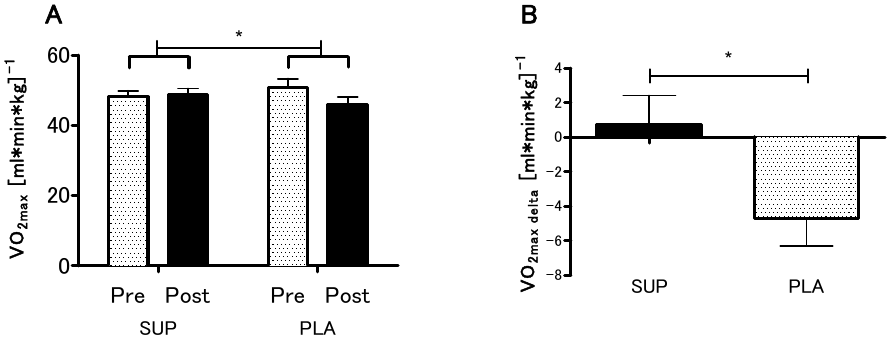
. ． Figure 3. E ff ect of vitamin D supplementation on VO 2max ( A ), and contrast between SUP versus PLA Figure 3. Effect of vitamin D supplementation on V O 2max ( A ), and contrast between SUP versus PLA deltas (post-pre) ( B ). Values are means. Error bars indicate ± SEM. * = p < deltas (post-pre) ( B ). Values are means. Error bars indicate ± SEM. * = p < 0.05.